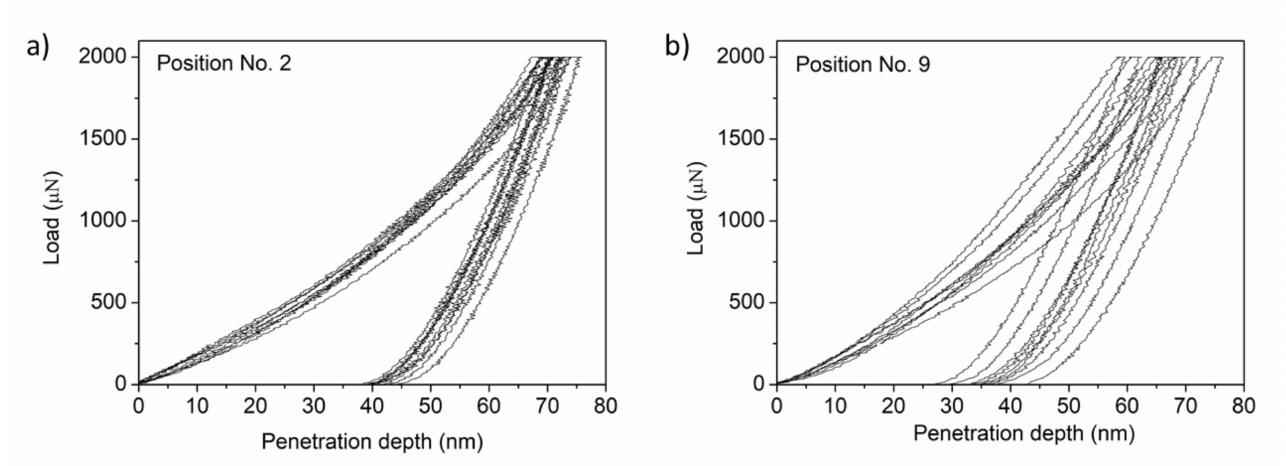
Figure 11. The load-depth curves obtained by nanoindentation for point Nos. 2 ( a ) and 9 ( b